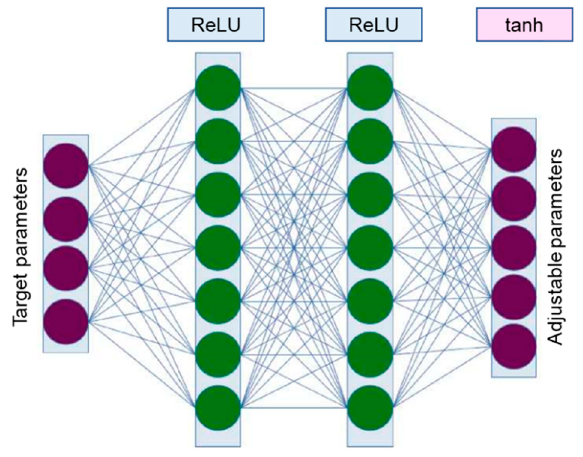
Figure 4. Decision-making module training.